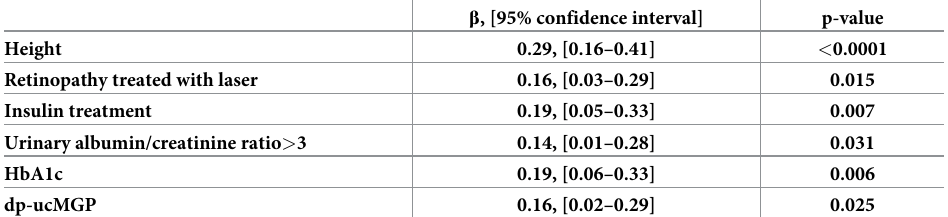
Table 4. Multivariate analysis: Correlations between clinical and biological variables and continuous NDS scoring. β , [95% confidence interval] p-value Height 0.29, [0.16–0.41] < 0.0001 Retinopathy treated with laser 0.16, [0.03–0.29] 0.015 Insulin treatment 0.19, [0.05–0.33] 0.007 Urinary albumin/creatinine ratio > 3 0.14, [0.01–0.28] 0.031 HbA1c 0.19, [0.06–0.33] 0.006 dp-ucMGP 0.16, [0.02–0.29] 0.025 Multivariate analysis was performed using ANCOVA. 95% confidence interval of the standardized coefficient is presented in brackets. Correlations are significant if p < 0.05. Significant results are presented in